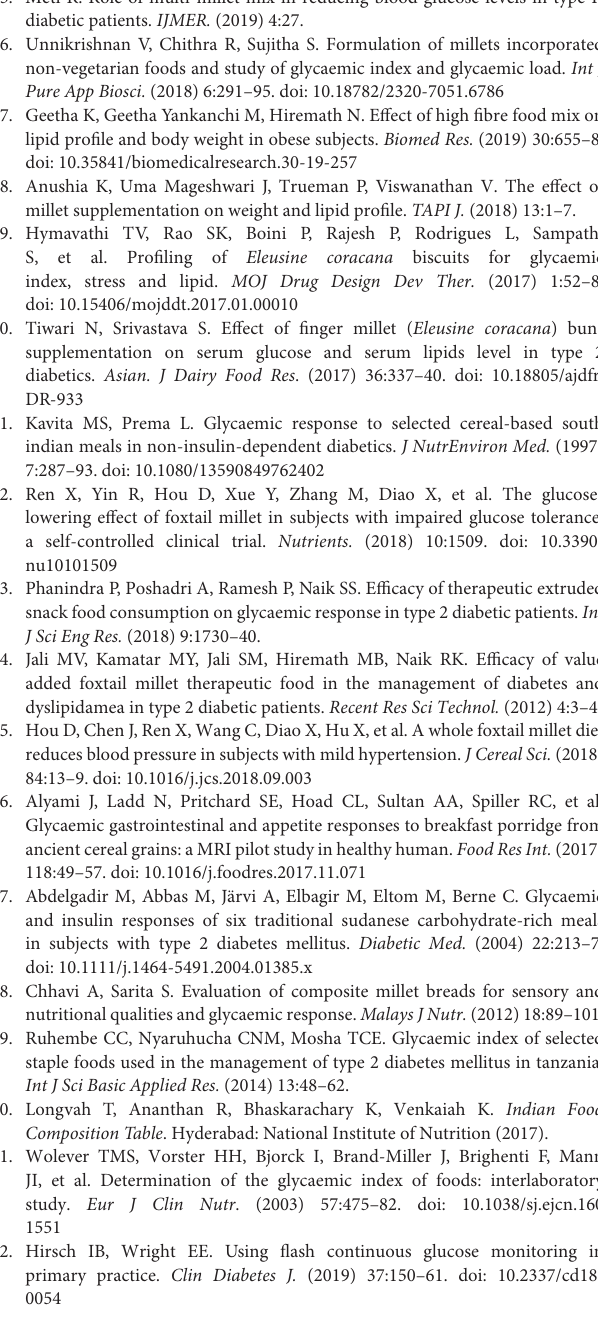
Composition Table . Hyderabad: National Institute of Nutrition (2017). 91. Wolever TMS, Vorster HH, Bjorck I, Brand-Miller J, Brighenti F, Mann JI, et al. Determination of the glycaemic index of foods: interlaboratory study. Eur J Clin Nutr . (2003) 57:475–82. doi: 10.1038/sj.ejcn.160 1551 92. Hirsch IB, Wright EE. Using flash continuous glucose monitoring in primary practice. Clin Diabetes J. (2019) 37:150–61. doi: 10.2337/cd18-